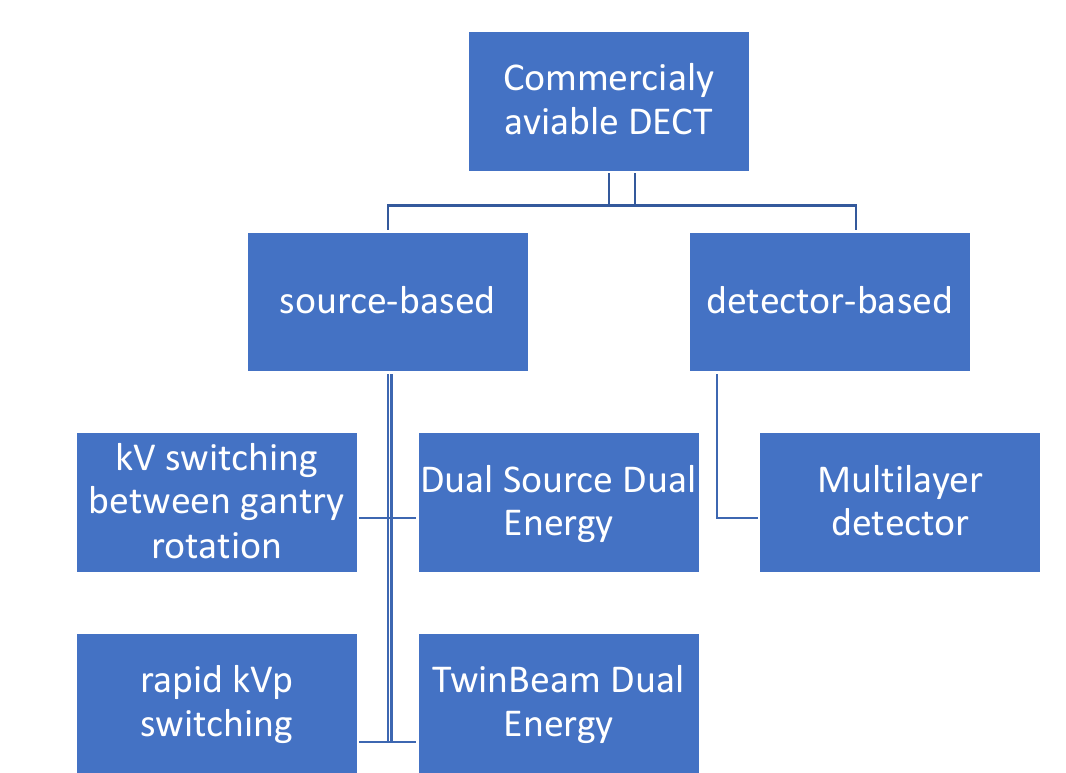
Figure 1. Technical source of dual-energy data. There are five commercially available types of CT scanners: four of them are source-based and only one is detector-based. DECT, dual-energy CT.